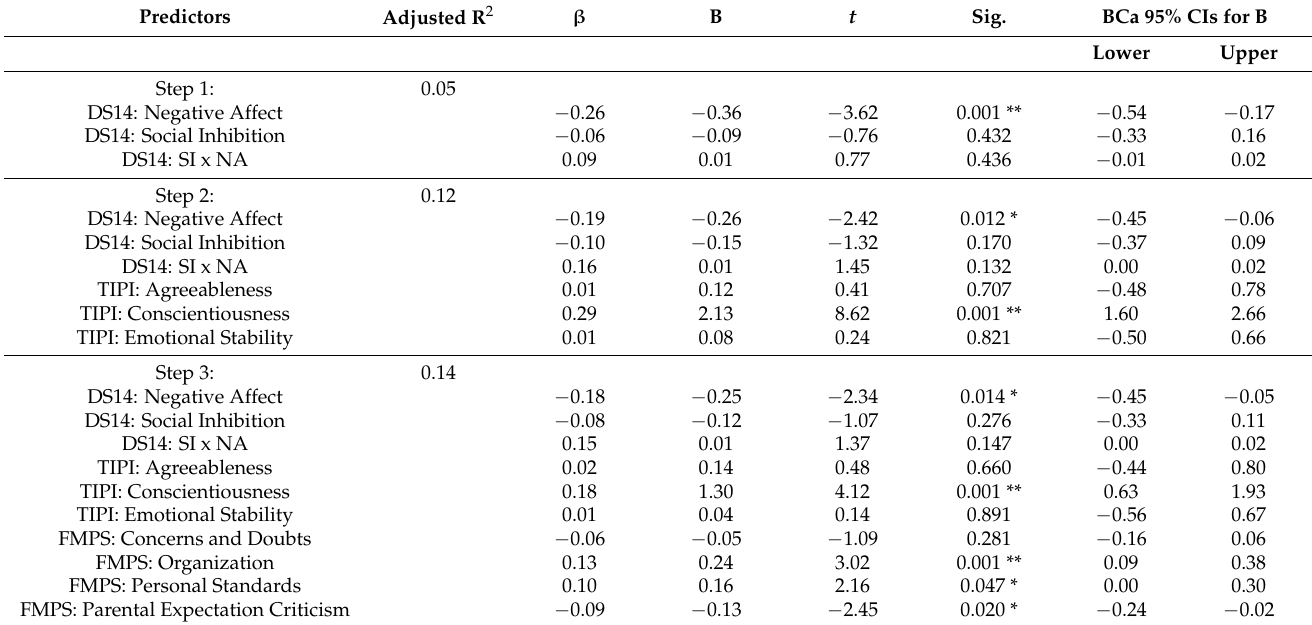
Table 3. Linear regression analyses with chronotype preference as the dependent variable; significant personality correlates as